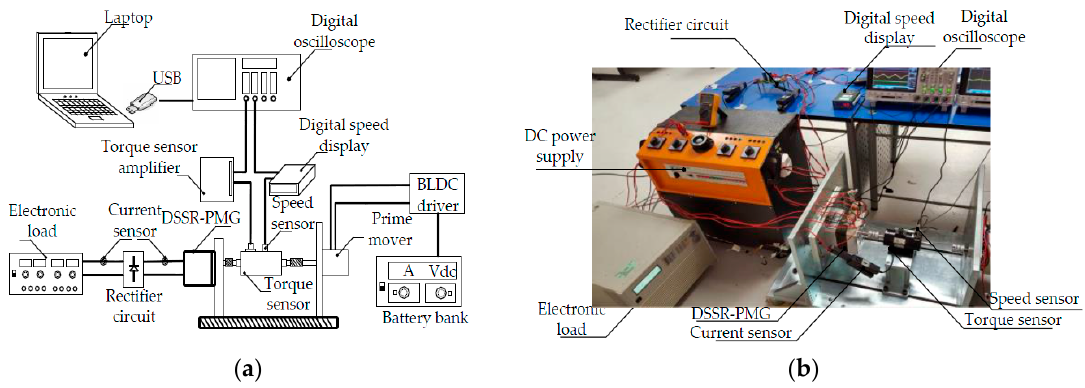
Figure 11. Block diagram and experimental setup of DSSR-PMG, ( a ) Block diagram for experimental setup; ( b ) Experimental setup for measurement.